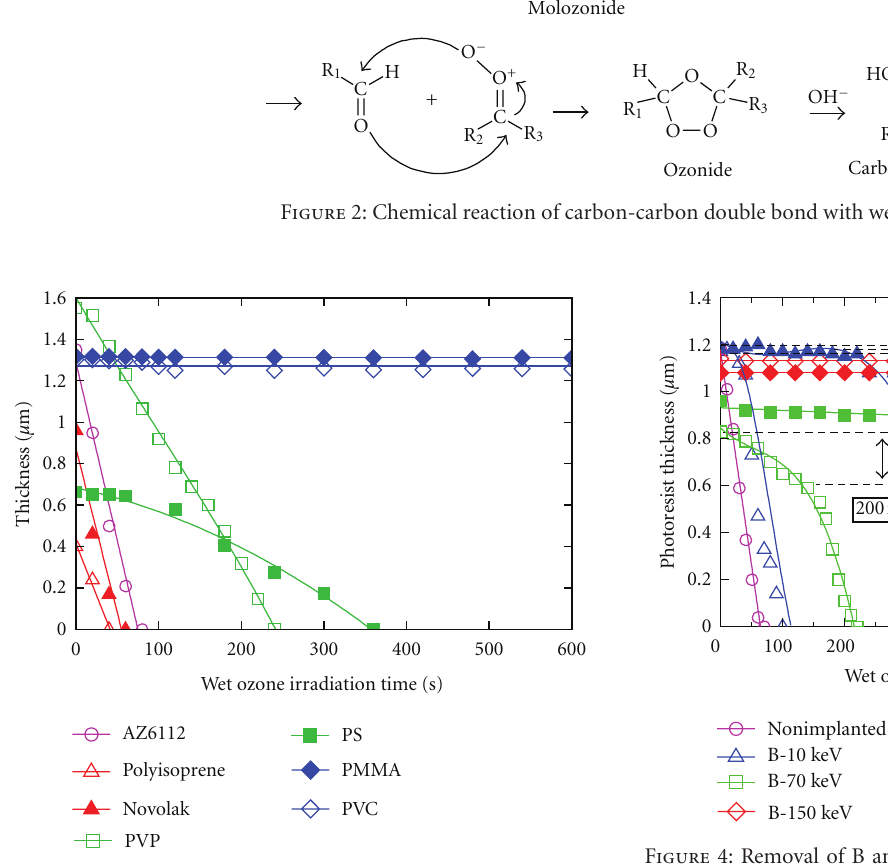
Figure 3: Dependence of polymer thickness on wet ozone irradia- tion time. Table 2: Removal rates of polymers using wet ozone. Polymer samples